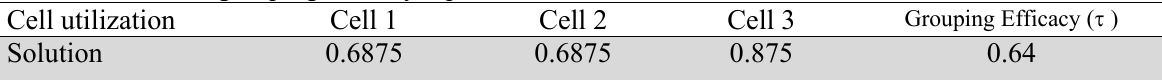
Cell utilization and grouping efficacy – problem Table